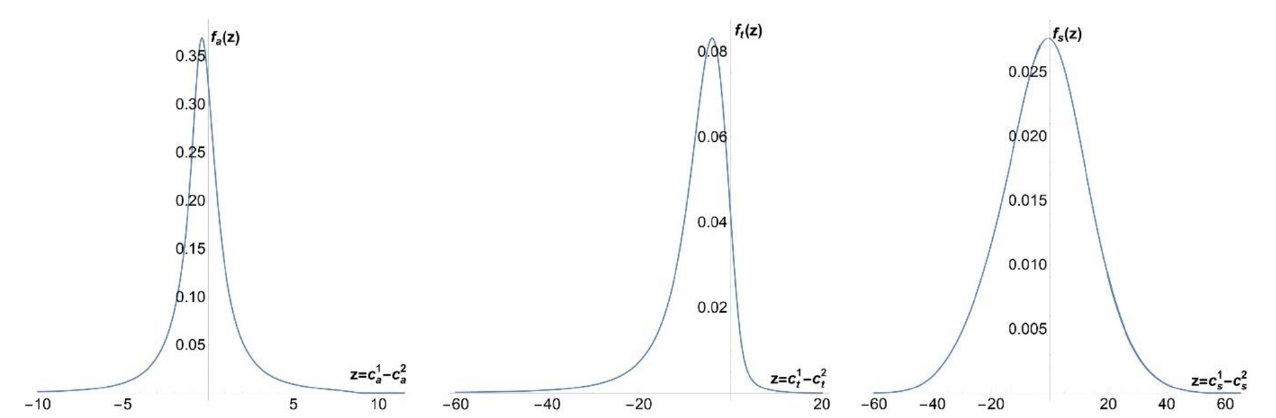
Figure 19. PDF of the NiTi-1 and NiTi-2 alloys corrosion rate differences under air, tide and sea